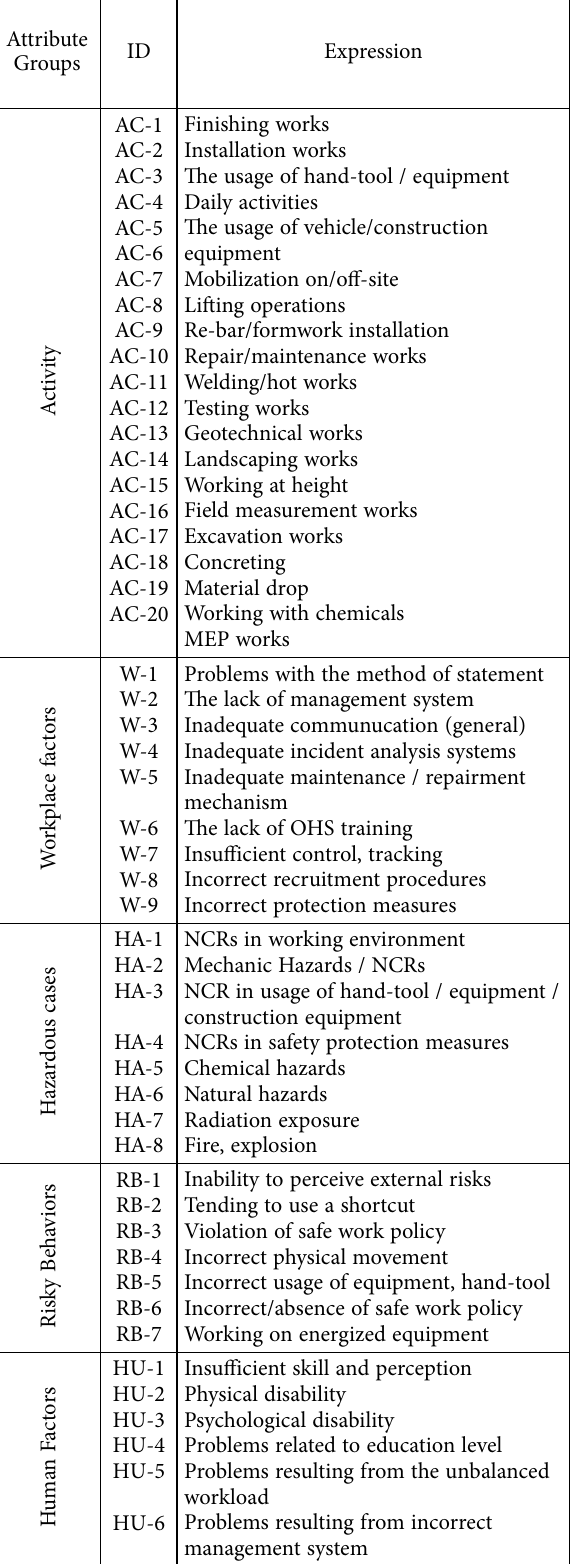
Table 1 . The master list of attributes used in this paper (based on the study of Ayhan and Tokdemir (2019a, 2019b)) Attribute Groups